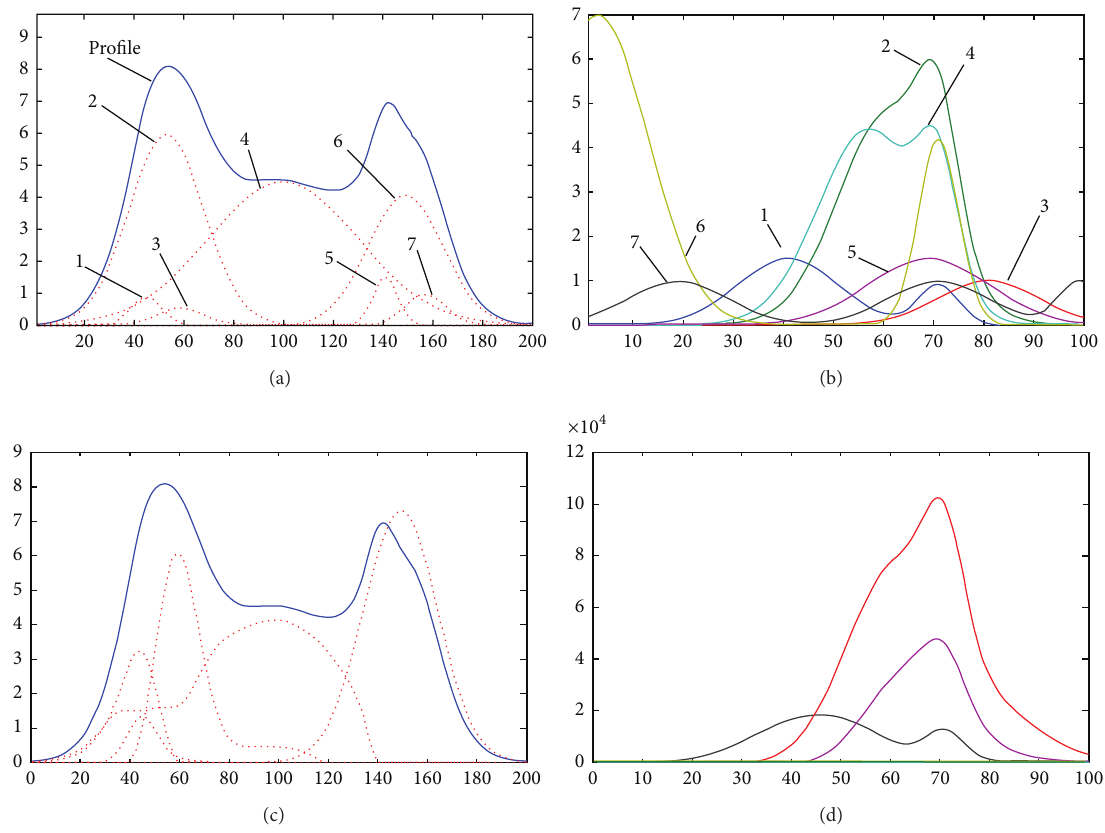
Figure 5: (a) The profile and simulated chromatogram peaks; (b) simulated spectra; (c) the calculated chromatogram peaks by MCR-ALS method; (d) the calculated spectra by MCR-ALS